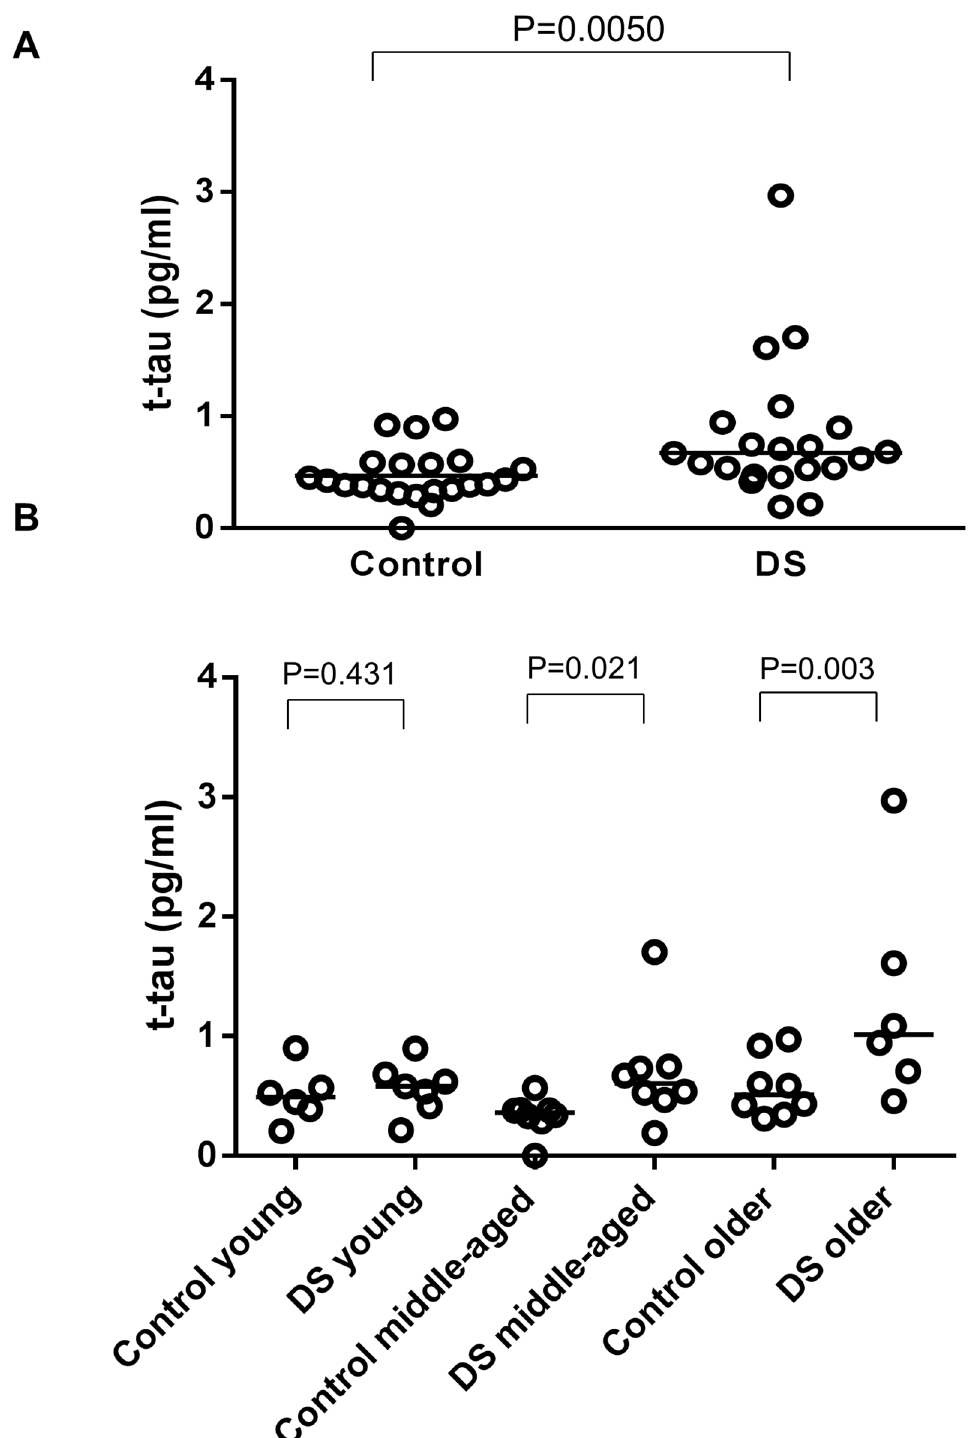
Fig 1. (A) Scatter plot for t-tau level in plasma in the control group (n = 22) and DS group (n = 21). Bars indicate medianvalues. Levels of t-tau in the DS group were significantly higherthan those of the control group (P = 0.0050). (B) Scatter plot for t-tau level in plasma in younggeneration(ages 14–25 years; n = 6 in the control group and 7 in the DS group), middle-agedgeneration (ages 26–42 years; n = 8 in the control group and 8 in the DS group), and older generation(aged older than 43 years; n = 8 in the control group and 6 in the DS group) generation. Bars indicate medianvalues. Levels of t-tau in the DS group were significantly higherthan those of the control group in the middle-agedgeneration and the older generation(P = 0.021 and 0.003, respectively).